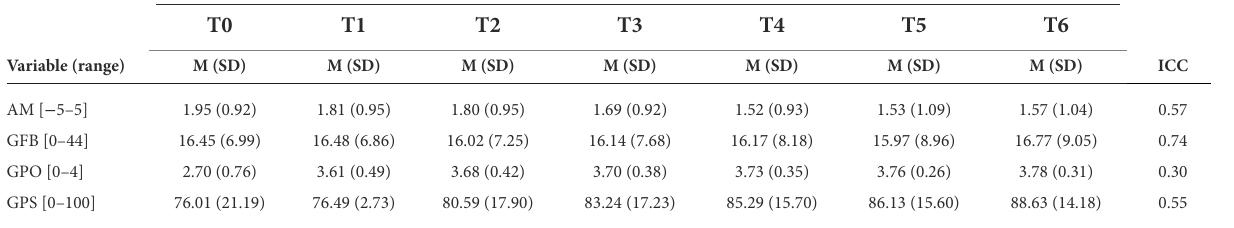
TABLE 1 Means, standard deviations, and ICC of variables of interest at times